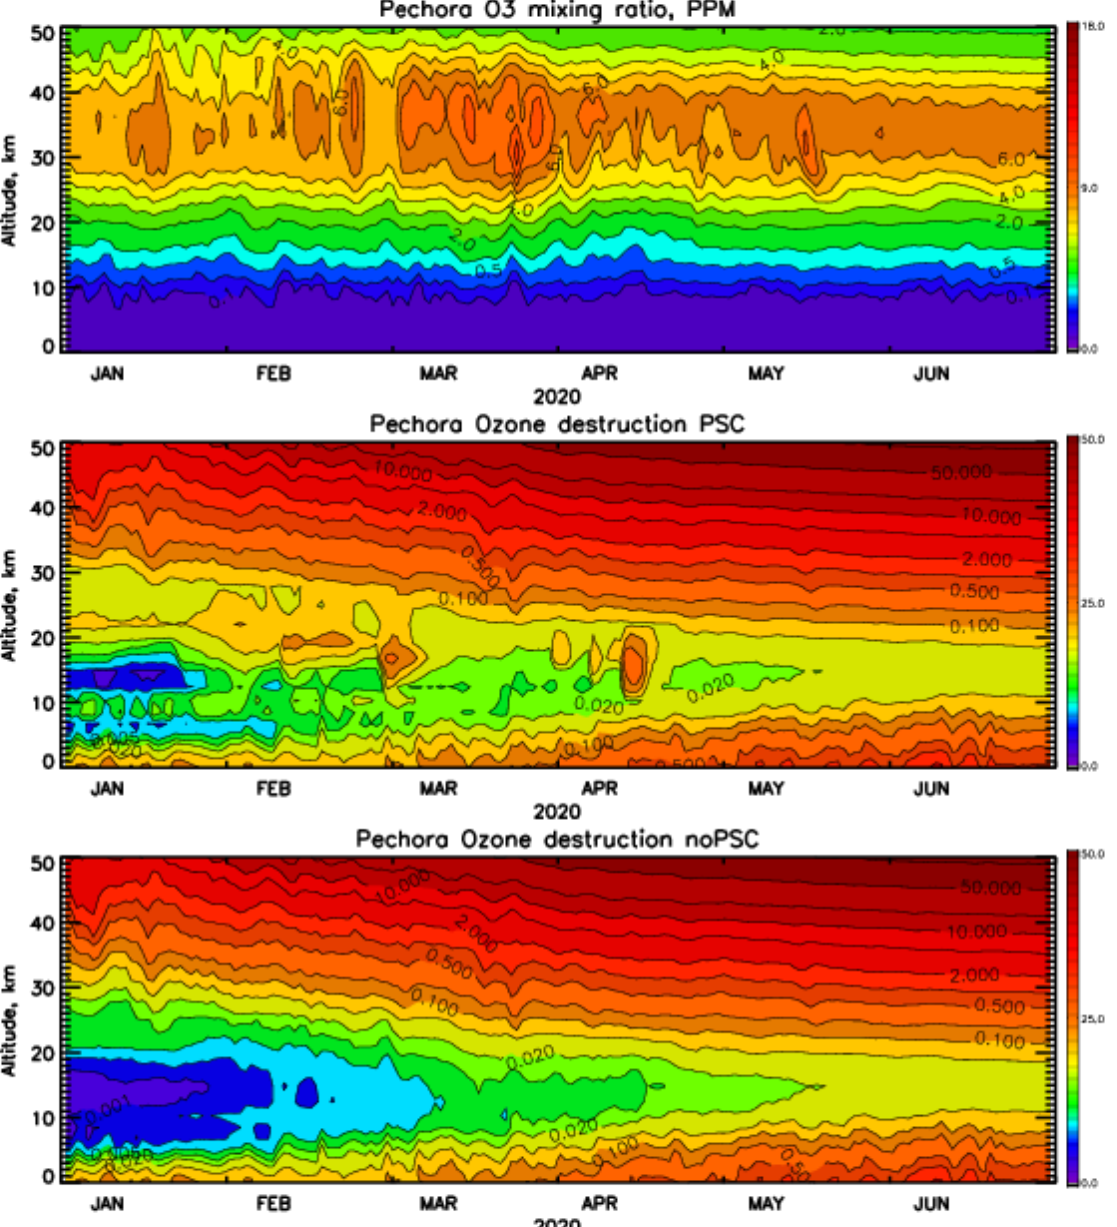
Figure 11. Ozone-mixing ratio at Pechora Station for the first half of 2020 ( top ), ozone destruction coefficient for PSC scenario ( middle ) and for noPSCscenario ( bottom ). For the scenario without taking into account the formation of PSCs (noPSC) in the area of the Pechora station, there was no local increase in the rate of destruction of odd oxygen, although an increase in the gas-phase destruction of odd oxygen was noted during the spring, both at the heights of the lower and upper stratospheres. No localized increase in the rate of gas-phase destruction of odd oxygen in the region of decrease in